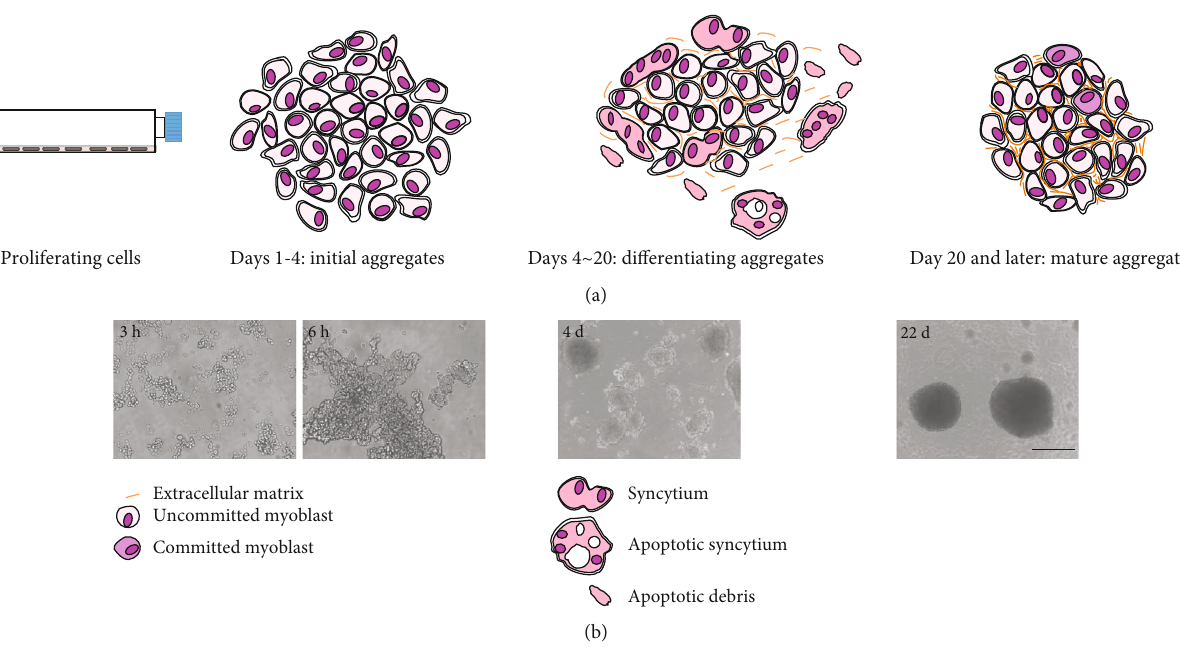
Figure 1: Scheme of myosphere evolution shown according to (a) culture time and (b) contrast phase